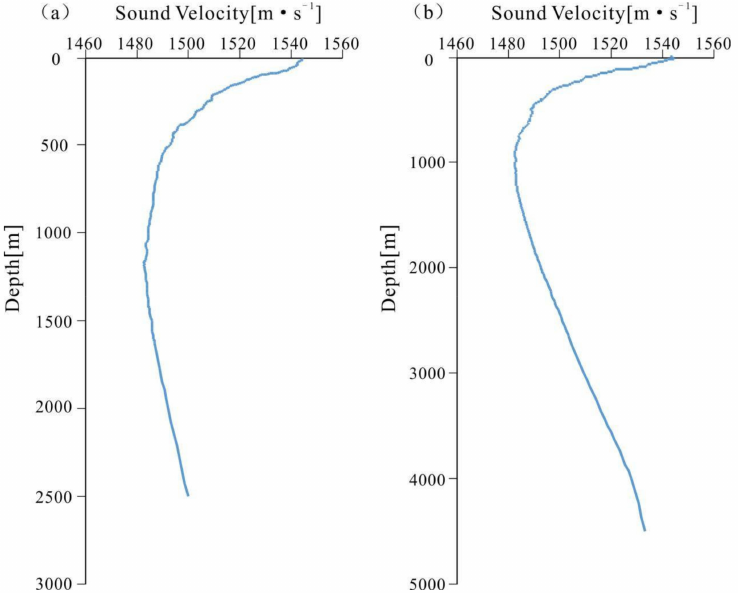
Figure 2. Variations of the sound velocity with depth measured by the sound velocity profiler. ( a ) Sound velocity profile from the surface to a water depth of 2500 m in the northern continental slope of the South China Sea; ( b ) sound velocity profile from the surface to a water depth of 4500 m in the central area of the South China